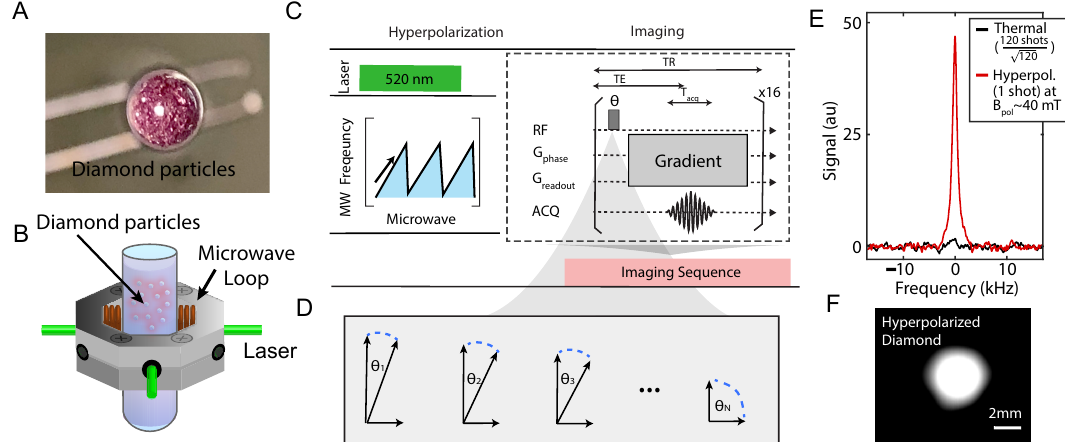
Figure 1. Experiment schematic. ( A ) A picture of diamond particles ( ∼ 200 µ m in size) contained in an NMR tube as an imaging phantom (taken from the bottom of a NMR tube). ( B ) Green laser excitation and MW irradiation is applied on the sample in order to transferred polarization to lattice 13 C nuclei from optically polarized NV- electrons in the microscopic scale. ( C ) Experimental protocol of hyperpolarizing and imaging diamonds. 13 C hyperpolarization occurs at 38 mT under MW sweeps across the NV-ESR spectrum, and then transferred to a MRI machine for imaging. Flip angles and gradient arrangement determine the quality of the MRI. ( D ) Illustration of flip angles for the n th repetitions. ( E ) Typical signal enhancement by hyperpolarization, showing signal gain against signal at 7 T. For a fair comparison, the noise in both is normalized to be 1 (dash line). ( F ) A typical MR image of diamond phantom in ( A